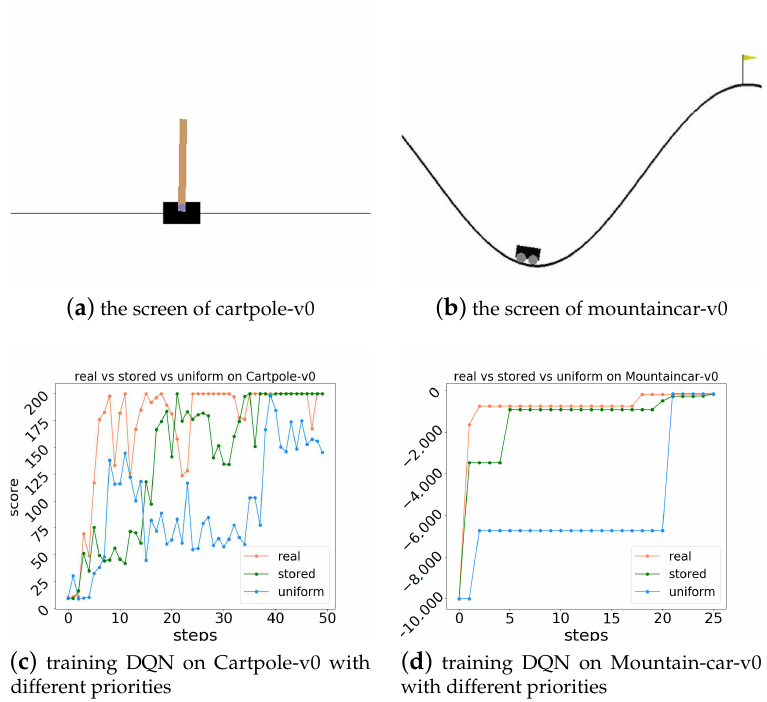
Figure 2. ( a ) Shows the screen of task cartpole. ( b ) Shows the screen of task mountaincar. ( c ) Shows the performance of DQN based on real, store and uniform priorities on task cartpole. ( d ) Shows the performance of DQN based on real, store and uniform priorities on task mountaincar. The orange, green, and blue curves represent real, store, and uniform priority, respectively.